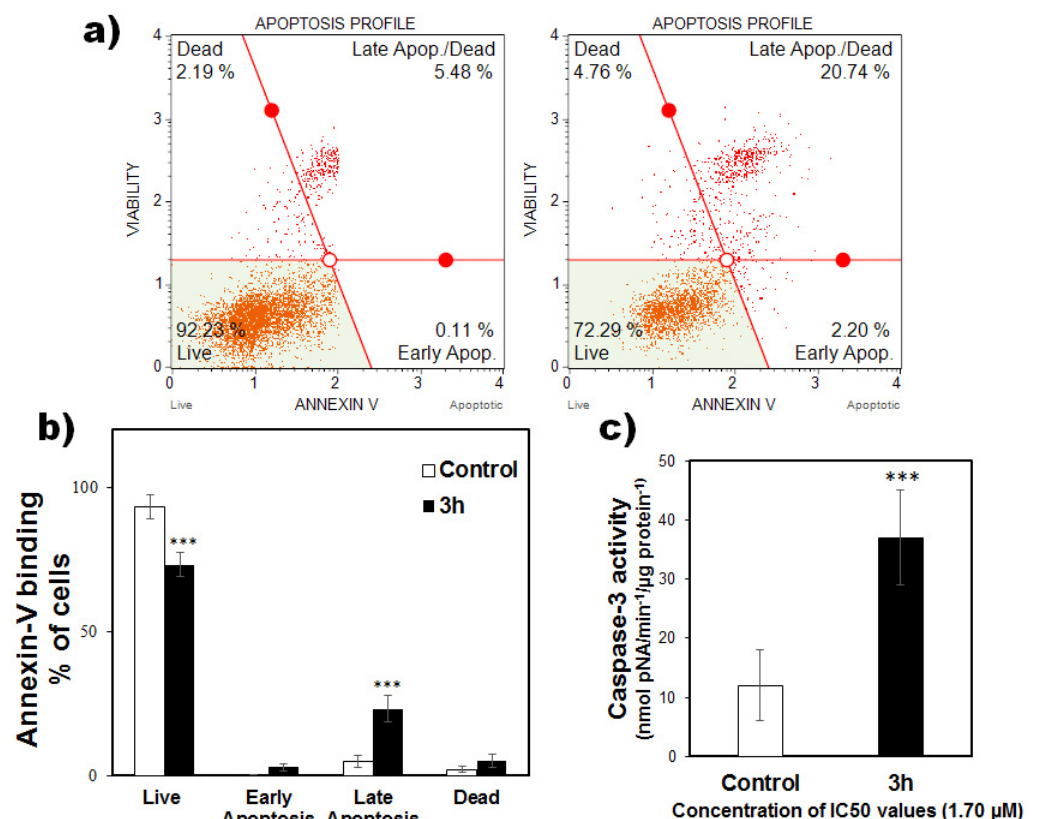
Figure 6 . Apoptosis profile for HT-29 cells treated with compound 3h (1.70 µM) a) Annexin-V binding b) The percentage of live, early and late ap- optosis/dead cells by MUSE cell analyzer c) Caspase‐3 activity (*** p < 0.001 vs